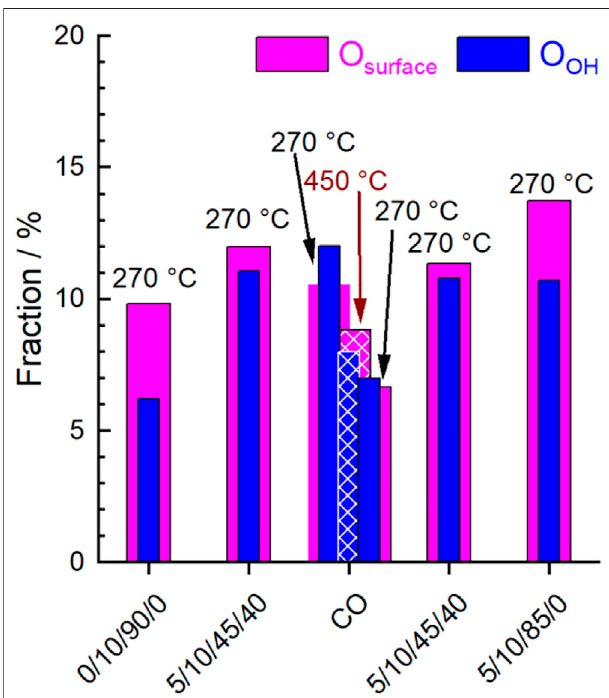
FIGURE 9 | Evolution of the fraction of O surface (magenta) and O OH (blue) extractedfromO1speak fi ttingatdifferenttemperaturesandfeeds(C 3 H 8 /O 2 / He/H 2 O) given below. Hatched columns represent fractions at 450 ° C, fi lled columns represent fractions at 270 °